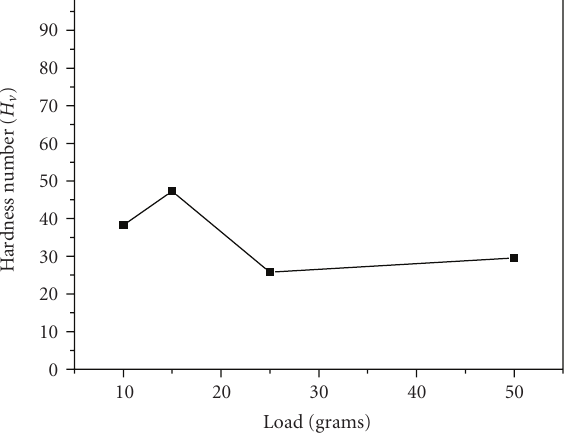
Figure 25: Microhardness versus Load for L-threonine.